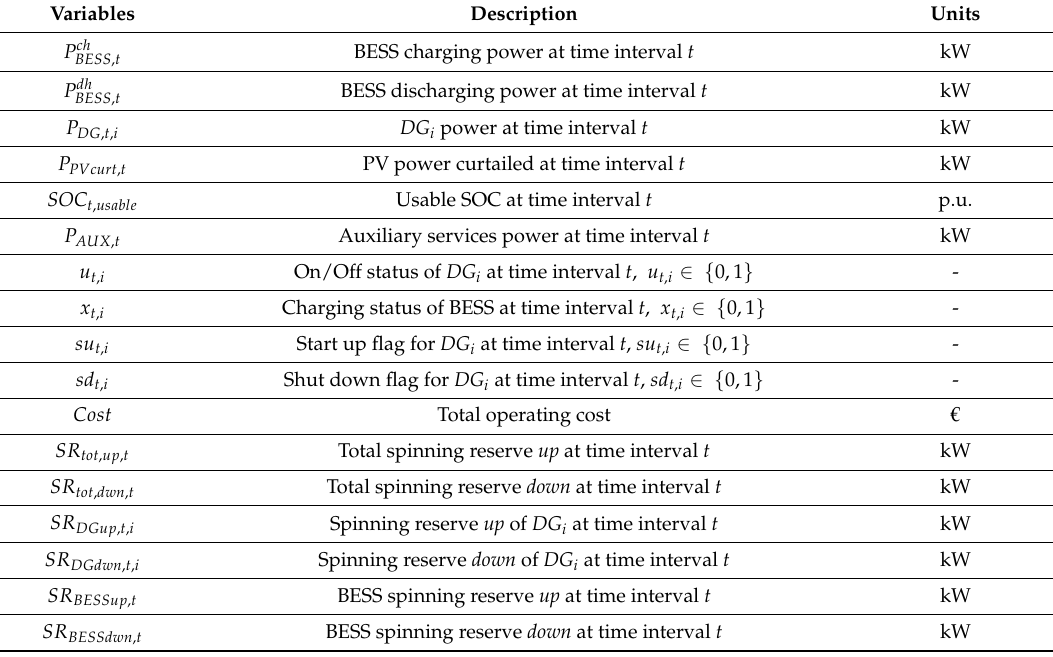
Table 9. List of variables in the MIP